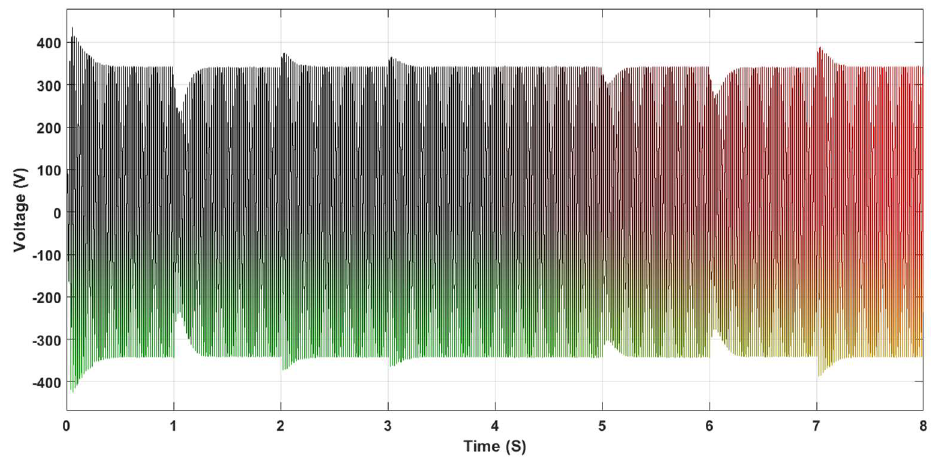
Figure 21. AC voltage across the AC load.